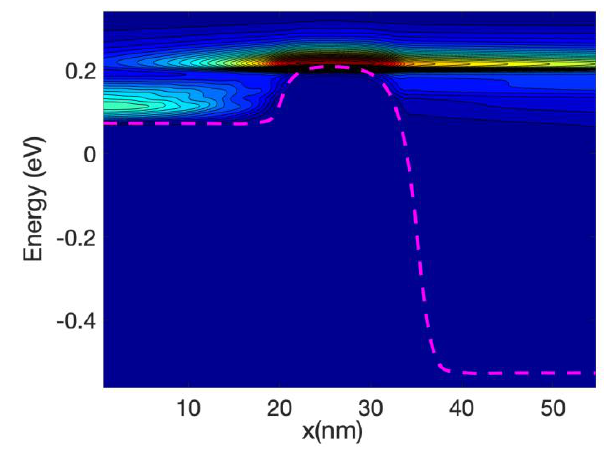
Figure 8. Energy-resolved current along the nanowire axis at Vg = 0.2 V. The first sub-band is shown by a dashed line. The electrons contributing to the current at the source (leftmost part in the figure) have lower energies than those at the middle of the device (or at the barrier top). Indicating large phonon absorption at the source (see the text).